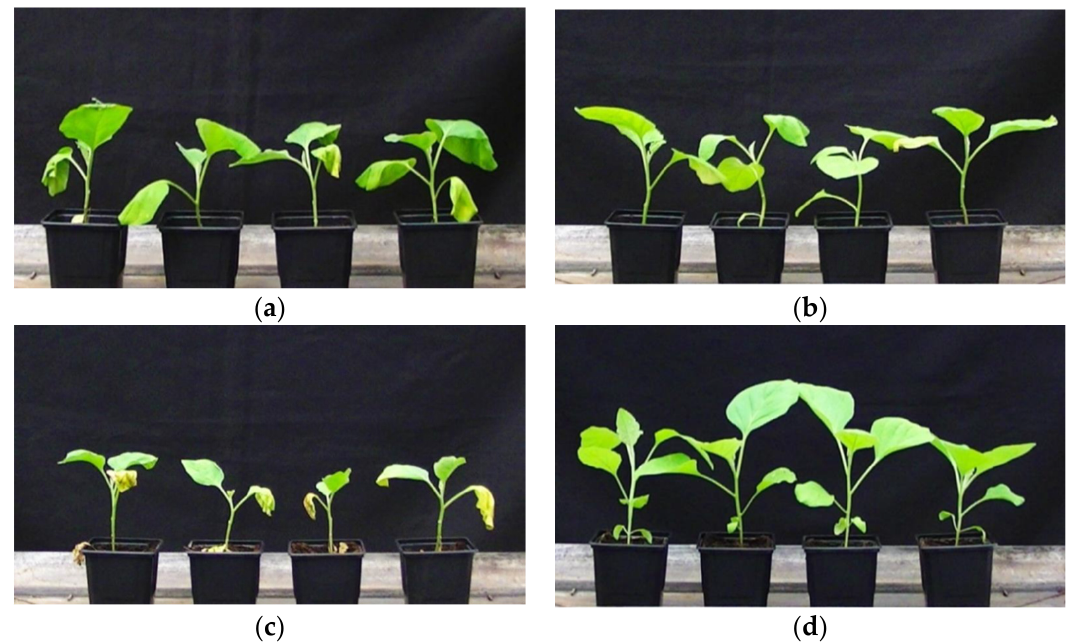
Figure 1. Verticillium wilt symptoms caused on NB ( a ) and PD ( b ) treated plants, controls ( V. dahliae inoculated) ( c ) and mock inoculated plants ( d ). The photograph was taken at 20 dpi.